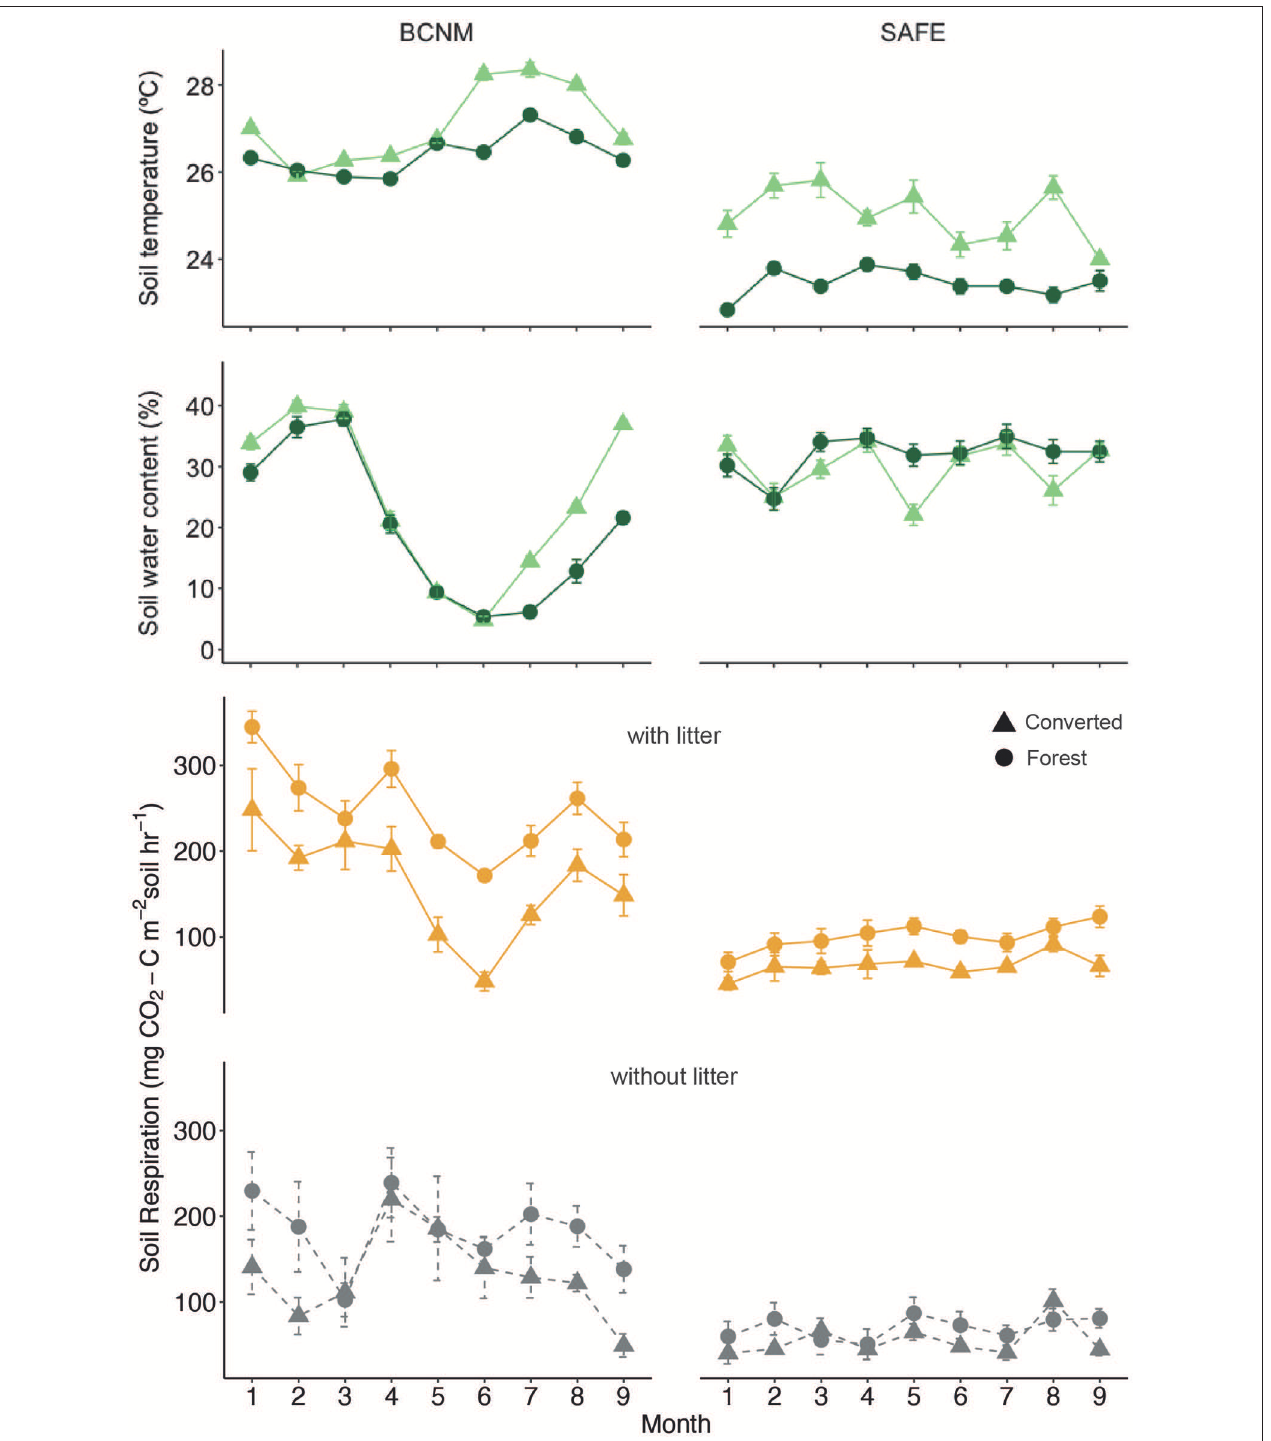
FIGURE 3 | Patterns of soil temperature (top panel), soil water content (second panel) and soil respiration (CO 2 efflux; bottom panels) in tropical forest (circles) or converted habitats (triangles) at SAFE in BCNM in Panama and at SAFE in Malaysian Borneo; soil respiration was measured over mesocosms with litter inputs (orange solid lines) and without litter (grey dashed lines). The experiment took place from March to November 2015 at SAFE and from October 2016 to June 2017 at BCNM; means and standard errors are shown for n = 24 per time point for soil temperature and soil water content, and for n = 6 per time point for soil respiration.